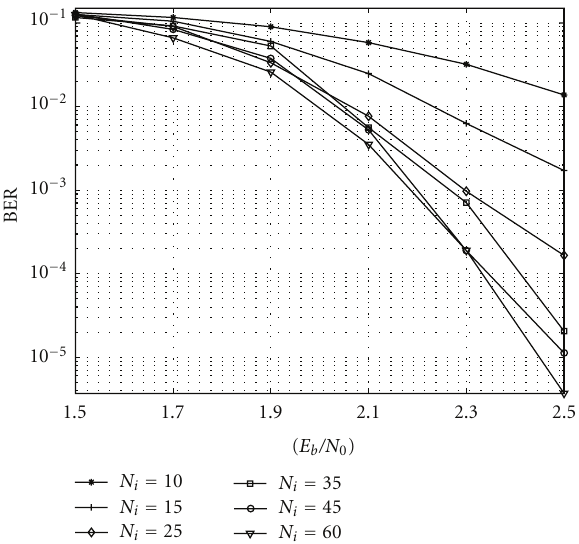
Figure 6: E ff ect of the population size for (16, 11, 4) 3 at 12th iteration on IGAD1.